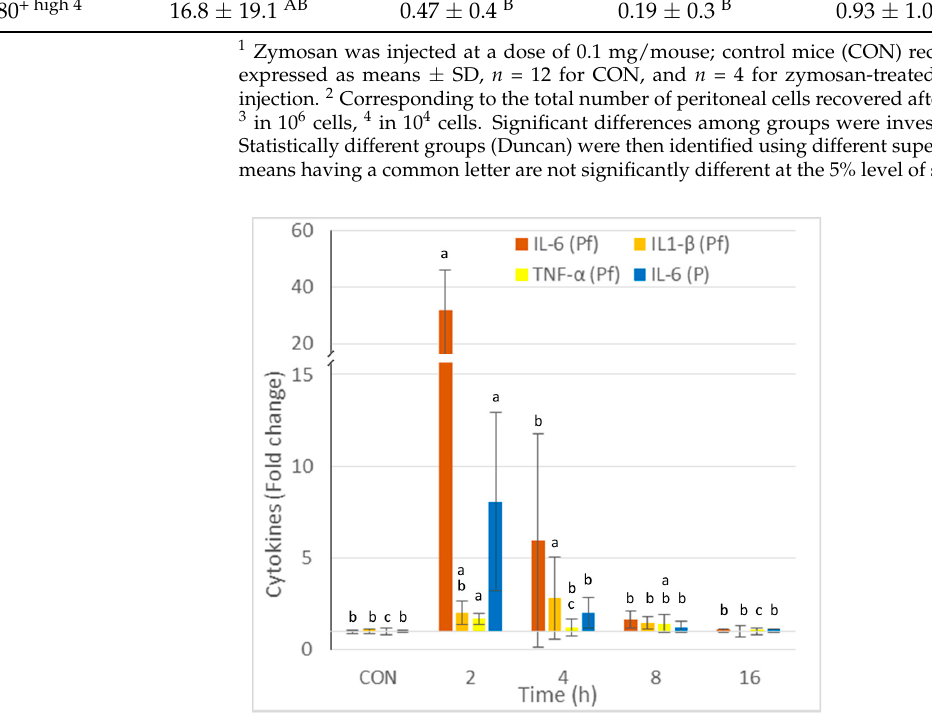
Figure 2. Effect of intraperitoneal administration of zymosan at a dose of 0.1 mg/mouse on the cytokines measured in the peritoneal fluid (Pf) and the plasma (P), expressed as fold-increase vs. the values measured in controls (CON) that received PBS only. Values are reported as means ± SD, n = 8 for the controls, and n = 4, for the mice treated at 2, 4, 8, and 16 h post-zymosan injection, respectively. Mean values of IL-6, IL1- β , and TNF- α in Pf, and IL-6 in P in CON were 27, 75, 51, and 758 pg/mL. Significant differences among groups were investigated using one way ANOVA. Statistically different groups (Duncan) were then identified using different apex letters ( p < 0.05). Any two means having a common letter are not significantly different at the 5% level of